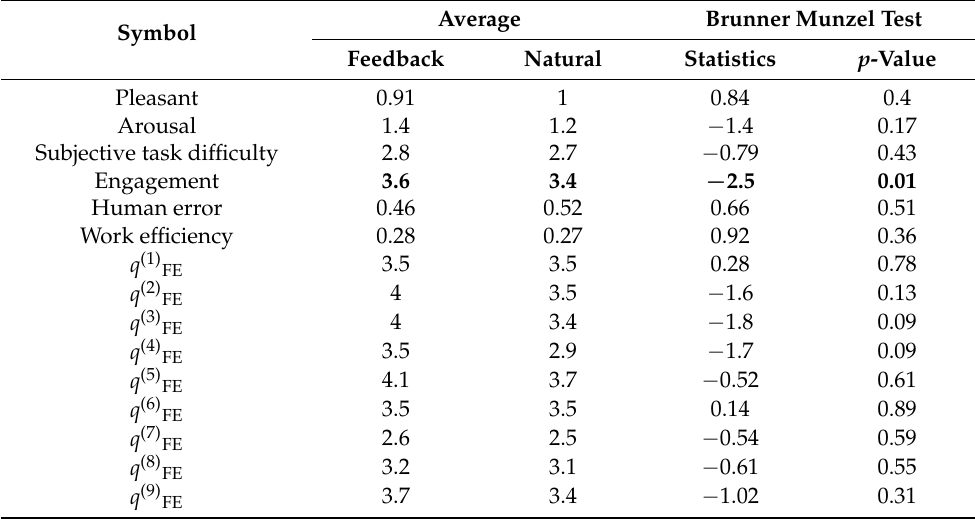
Table A2. Effect of feedback on pleasant emotion, Arousal, subjective task difficulty, engagement, human error, work efficiency, and flow